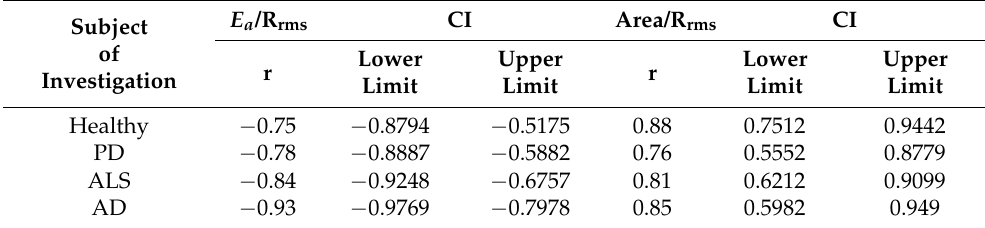
Figure 4. Young’s moduli of platelets from the healthy individuals and patients with PD, ALS and AD pathologies. Table 2. Pearson’s correlation coefficient, r, calculated for the parameter pairs E a /R rms (Young’s modulus and membrane roughness) and Area/R rms (platelet’s area and membrane roughness), for healthy and NDD platelets. The 95% confidence intervals (CI) for Pearson’s correlation are